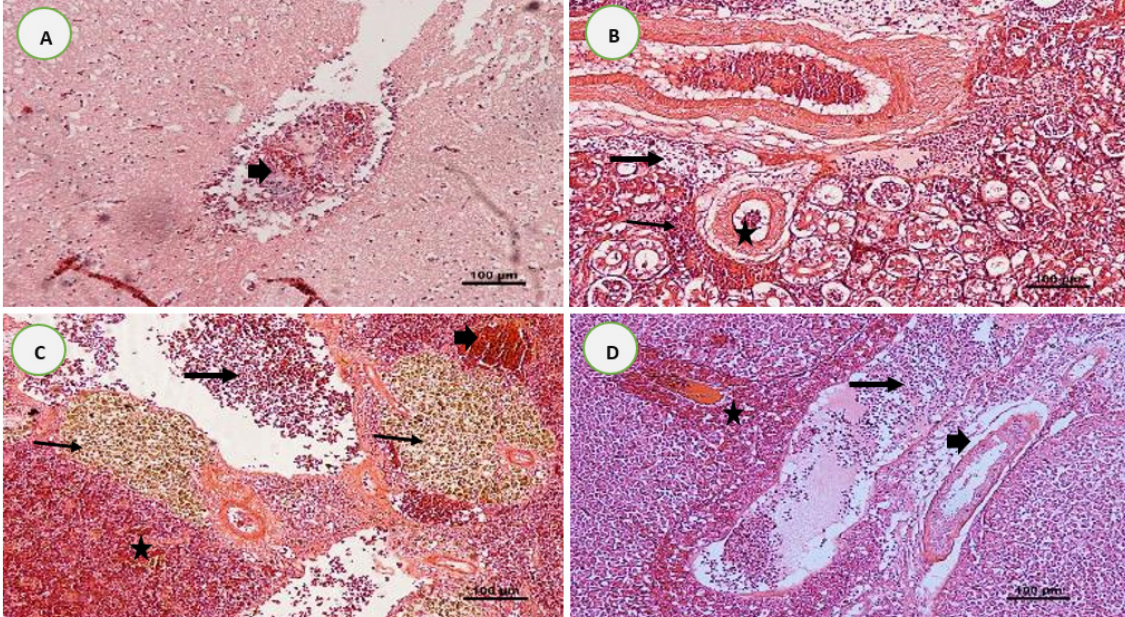
Figure 15. Histological findings in the organs of red tilapia post-challenge with Streptococcus